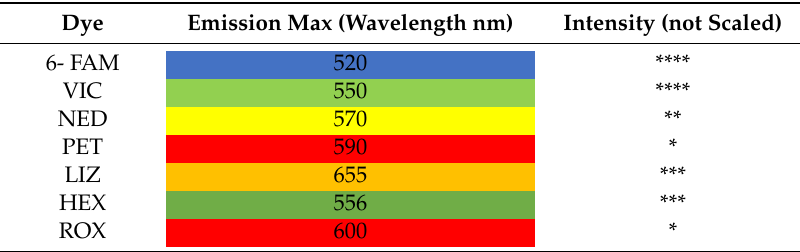
Table 6. Emission spectra of fluorescent